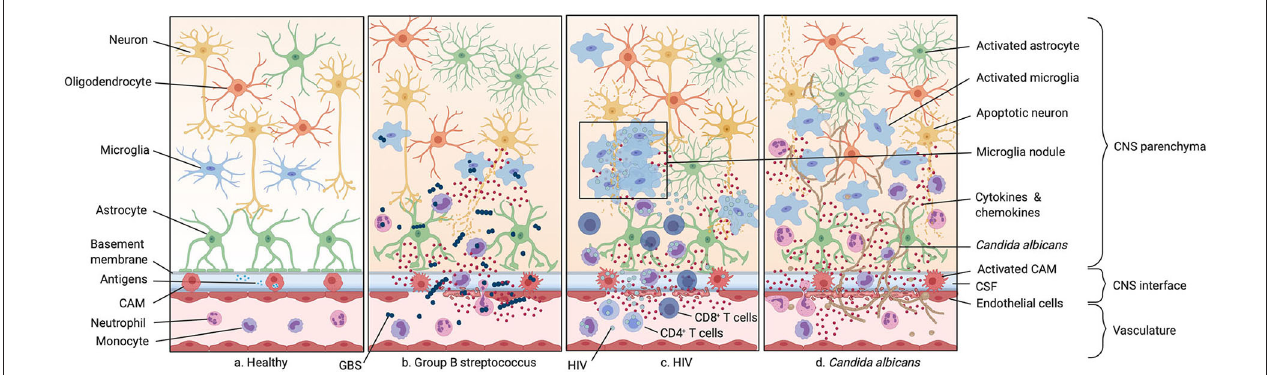
FIGURE 3 | Infections of the neonatal CNS. (a) Illustration of the healthy CNS including the vasculature, the perivascular space, and the brain parenchyma. (b) Group B streptococcus (GBS) infection. GBS enters the CNS either paracellularly, via transcytosis or exploiting trafficking phagocytic host cells. This leads to the secretion of inflammatory cytokines by resident macrophages in the perivascular space and meninges. As GBS spreads more into the CNS this inflammatory response is also mounted by endothelial cells and microglia, leading to leakage of the BBB and therefore an increase number of monocytes and neutrophils in the CNS. (c) HIV infection. HIV infects CD4 + T cells, monocytes, and macrophages. Infection of circulating monocytes helps HIV to enter the CNS where it infects other tissue-resident macrophages. This leads to an acute immune response with secretion of proinflammatory cytokines. (d) Candida albicans infection. Candida albicans enters the CNS either para- or intracellularly or shuttled inside circulating monocytes. Infection of the CNS leads to an activation of microglia, astrocytes, and oligodendrocytes resulting in the secretion of cytokines and chemokines and subsequently to the recruitment of neutrophils and other circulating